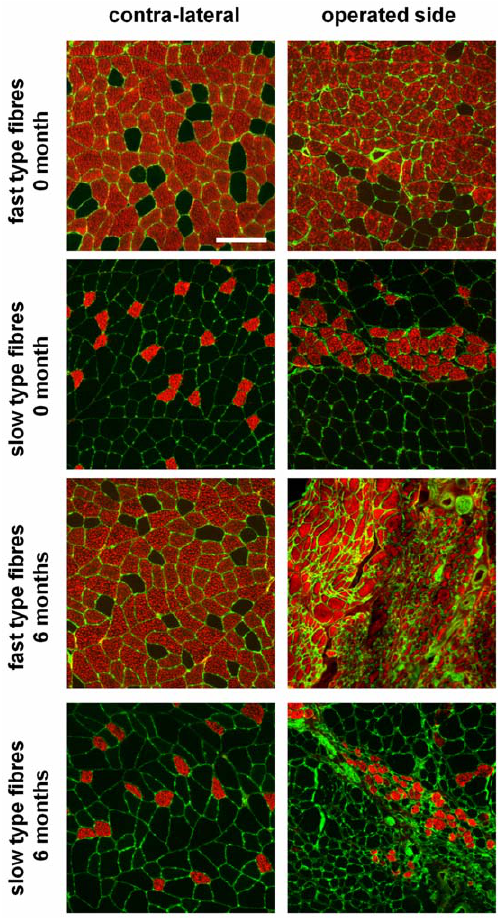
Figure 7. Fast type and slow type gastrocnemius muscle fiber morphology. (A) Transverse sections of contra-lateral and operated side muscles were stained with laminin antibody (green) and either fast type or slow type myosin heavy chain protein antibody (red). Samples shown are from animals undergoing immediate repair (0 months) or delayed repair (6 months). Scale bar=100 m